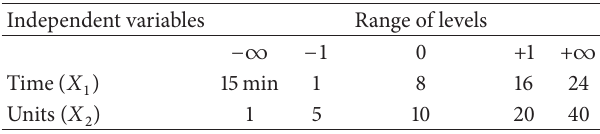
Table 1: Independent variables and the concentration levels studied in